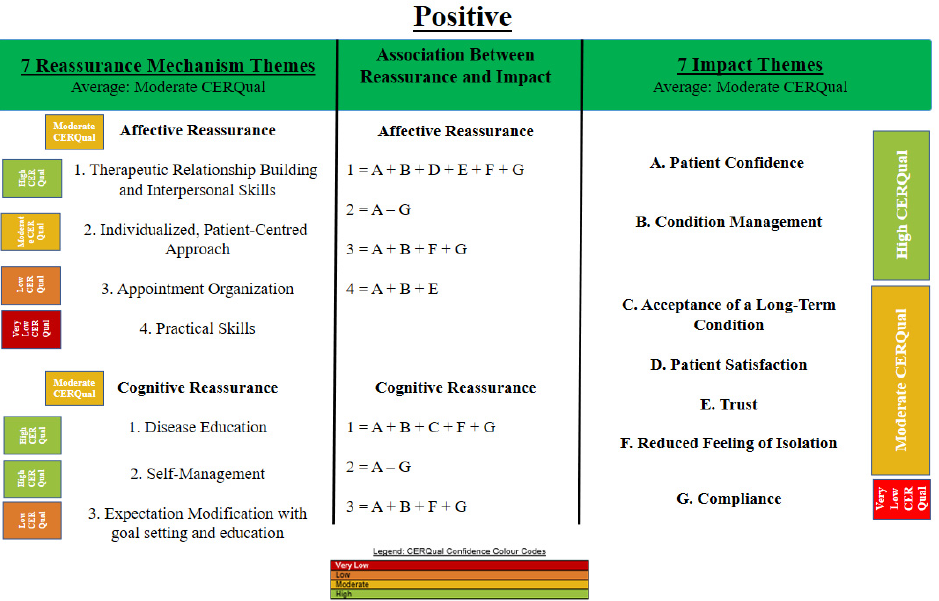
Figure 3. CERQual summary of thematic findings displaying the negative impact of reassurance and mechanisms. Note: View this figure from left to right. The left of the figure identifies mechanisms within interactions. The association between